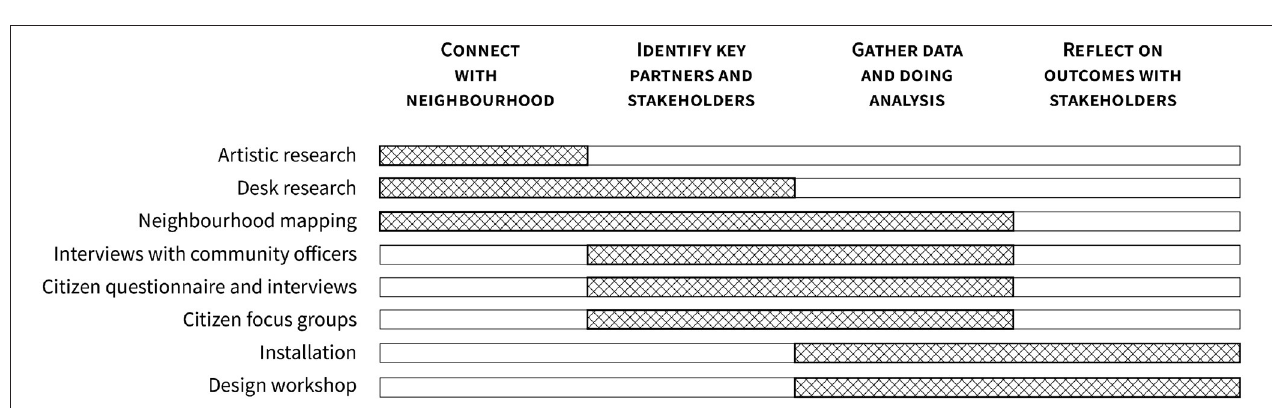
FIGURE 2 | The researchers invited citizens for an interview or to fill out the questionnaire in the mobile unit.